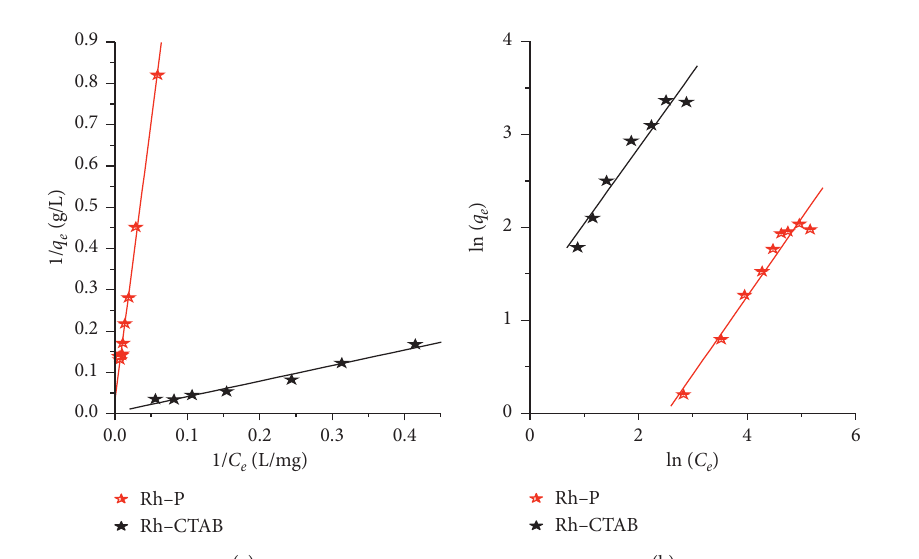
Figure 11: Linear representation of thymol adsorption isotherms onto the Rh-P and Rh-CTAB: Langmuir (a) and Freundlich (b). Table 7: Langmuir and Freundlich fitting parameters for the adsorption of thymol onto the Rh-P and Rh-CTAB. Langmuir Freundlich Samples q max